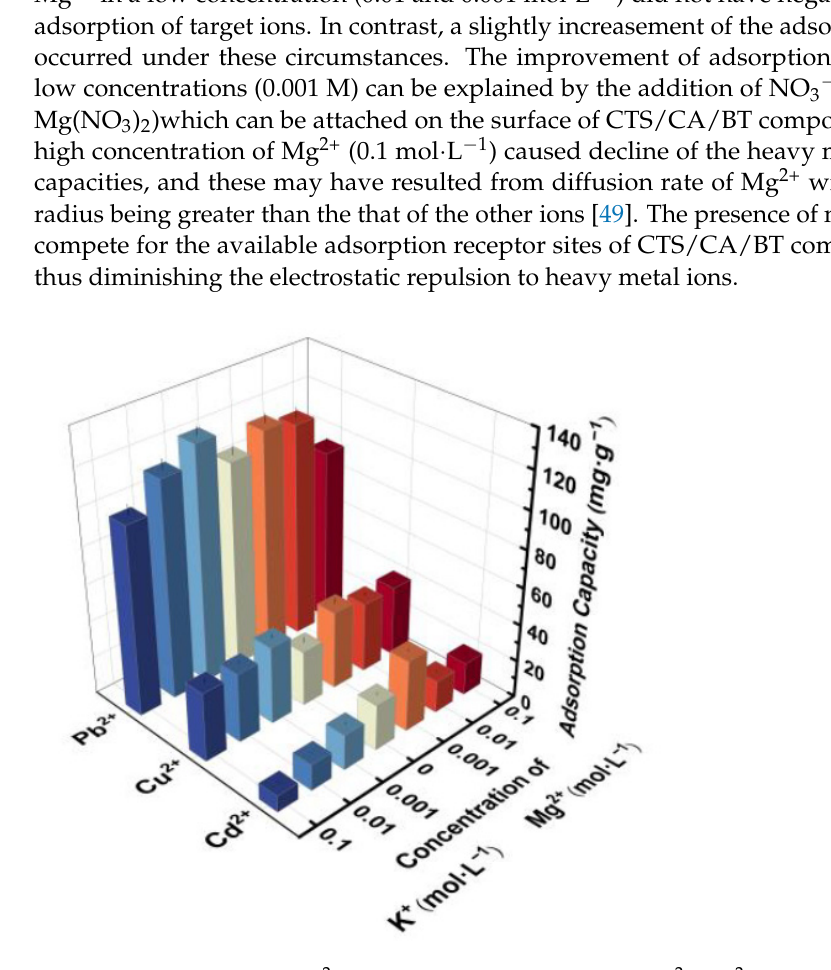
Figure 7. Effect of K + and Mg 2+ on the adsorption capacities of Pb 2+ , Cu 2+ and Cd 2+ on CTS/CA/BT composite hydrogel.